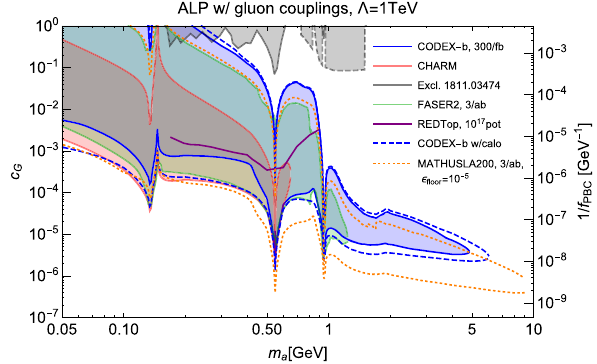
Fig. 12 ReachofCODEX-bforgluon-coupledALPs.Theverticalaxis on the left corresponds to the couplings defined in Eq. (3), while the one on the right to the normalization used in the PBC study [25]. The baseline (tracker only) CODEX-b design is shown as solid, while the gain by a calorimeter option is shown as dashed. See Fig. 34 for fur- ther information about how the CODEX-b reach changes with different detector designs. FASER2 and REDTop curves are taken from [25], after rescaling to the different lifetime/branching ratio calculation used here. The CHARM curve has been recomputed with the same assump- tions used for the CODEX-b curve. The MATHUSLA reach is based on our estimates, see text for